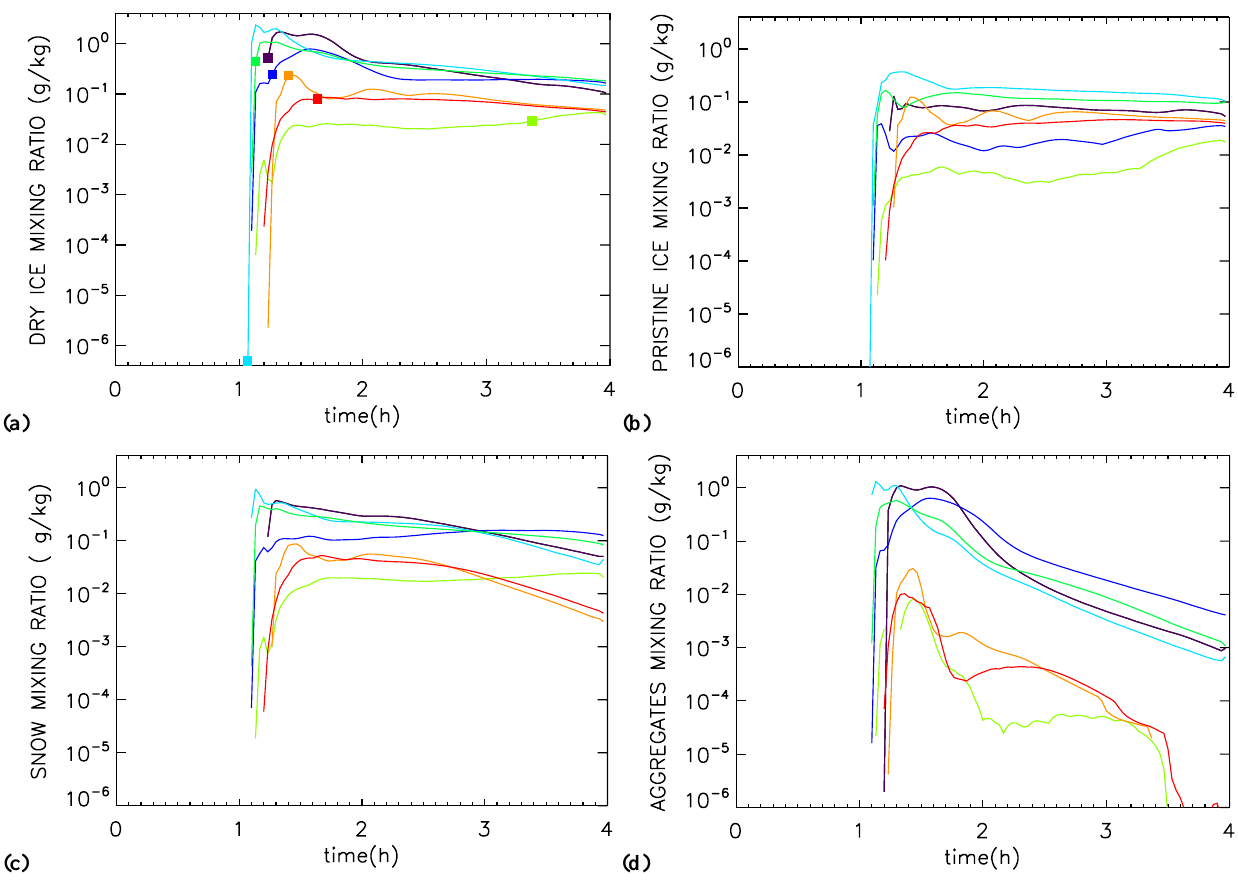
Fig. 5. Same as Fig. 4 but for the RUN1M